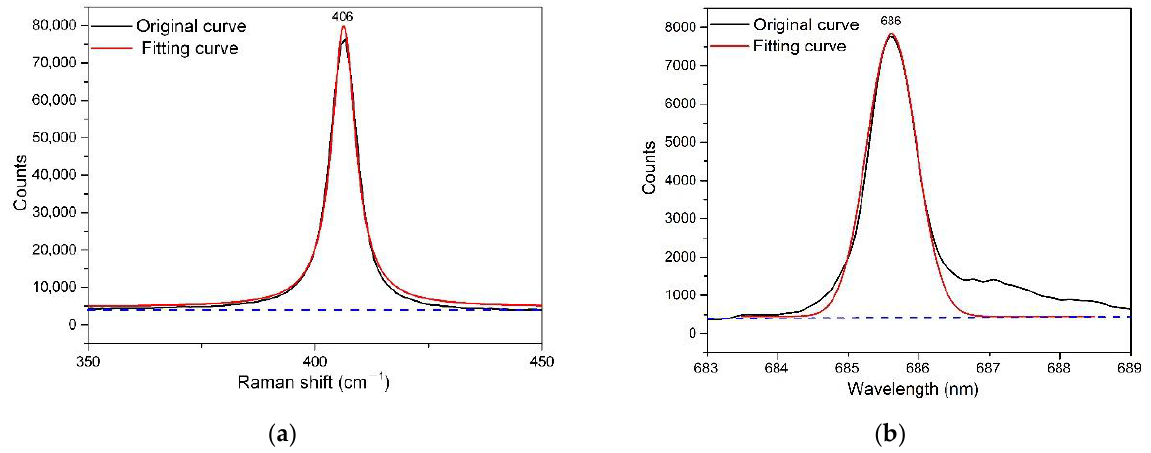
Figure 20. ( a ) The Lorentz fitting of the 406 cm −1 line of TS10. ( b ) The Lorentz fitting of the 686 nm line of TS10.